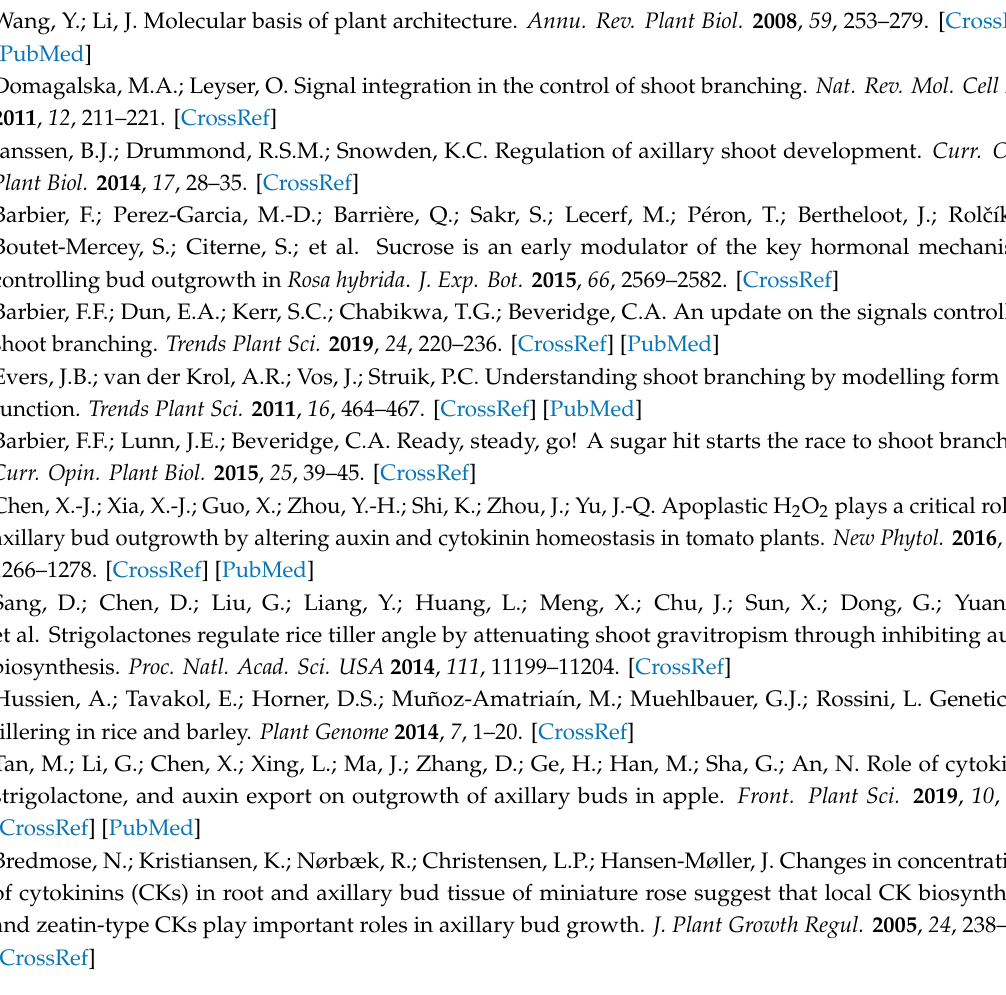
Figure S1: Histological studies on axillary meristem development of GA 3 -treated plants, Figure S2: The nucleotide sequence and the deduced amino acid sequence of AsGA20ox CDS, Figure S3: The nucleotide sequence and the deduced amino acid sequence of AsINV CDS, Figure S4: Comparison between the log2 of expression ratios of DGEs obtained from RNA-seq and RT-qPCR, Figure S5: Average temperature per month and total sunshine hours per month in the plastic tunnel, Figure S6: Sample for measuring endogenous plant hormone level, sugars content, soluble protein content and related genes expression in 1 cm-thick stem containing shoot apical meristem, Table S1: List of 159 DEGs in this study, Table S2: Primers used in this